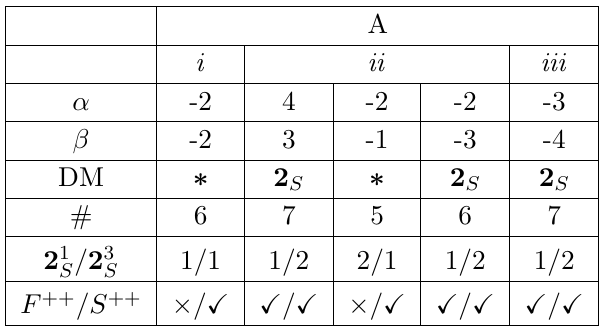
Table 3. The same as in table 2 for Class 1.b of (cid:12)gure 1.